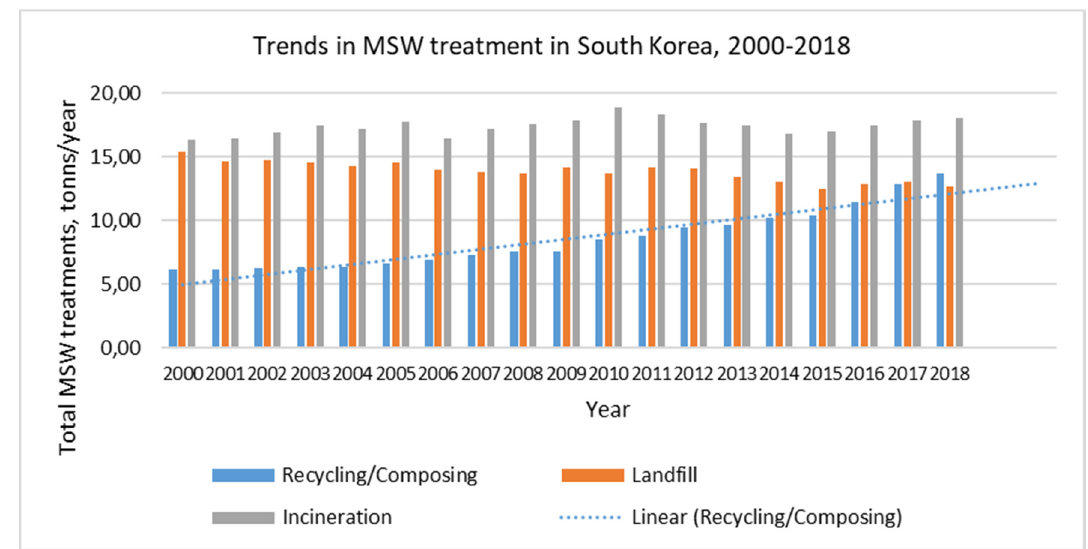
Figure 1. Trends in Municipal Solid Waste treatment in South Korea, 2000–2018. Source: Korea’s Environmental Review, 2018, Ministry of Environment, ECOREA, http://eng.me.go.kr [9].